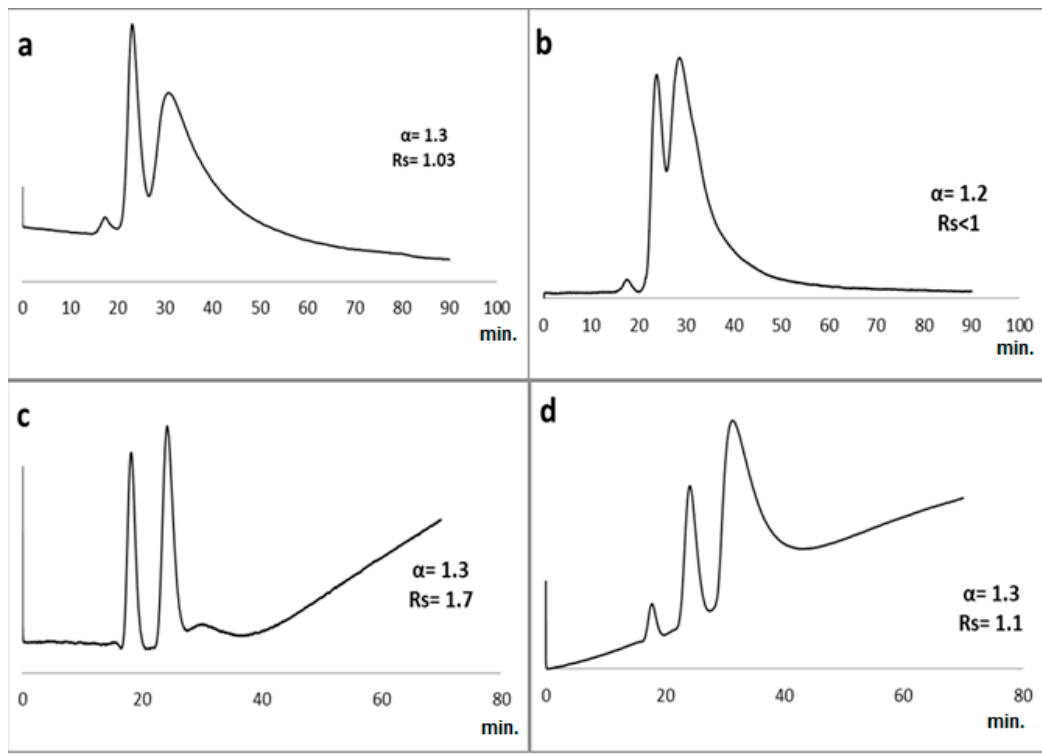
Figure 4. Enantioselective nano-LC separation of; ( a ) racemic 4-hydroxy-3-methoxymandelic acid ( 35 ); ( b ) phenylalanine ( 30 ) (mobile phase: methanol/water 40:60 v / v ,); ( c ) tyrosine ( 29 ) and ( d ) O - methoxymandelic acid ( 34 ) on a C1 capillary column (150 µm ID, 25 cm length). UV: 219 nm, flow rate: 1 µL/min. Table 1. Chromatographic data, separation and resolution factors for the significantly resolved compounds, using reversed mobile phases, flow rate: 1 µL/min. Column C1 (Colistin Sulfate)